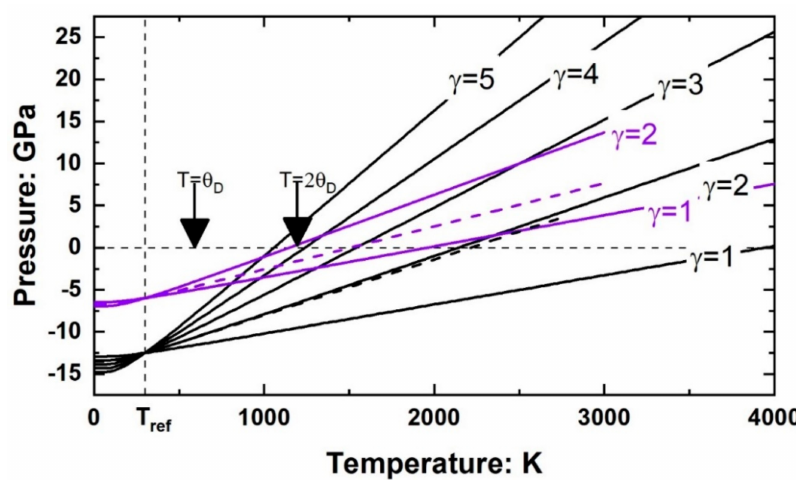
Figure 3. Isochors for two sets of MGD EoS with di ff erent values of γ , at volumes corresponding to the respective P lim . The black lines are for the olivine-like compressional BM2 EoS with K (cid:48) 0 = 4, and the purple lines are for the orthopyroxene-like compressional BM3 EoS with K (cid:48) 0 = 9. All the MGD EoS shown have θ D = 600K. Solid lines have q = 0. Dashed lines have γ 0 = 1 and q = 5. The temperatures corresponding to θ D and 2 θ D are